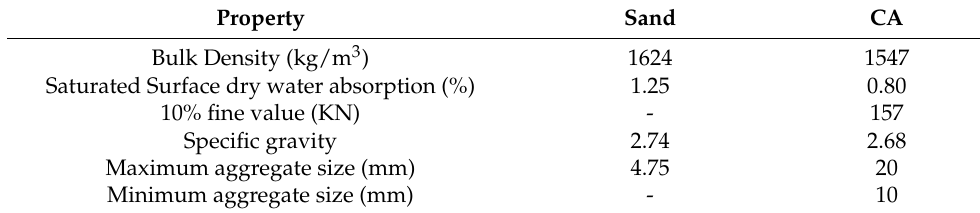
Table 3. The characteristics of sand and CA used in the study.